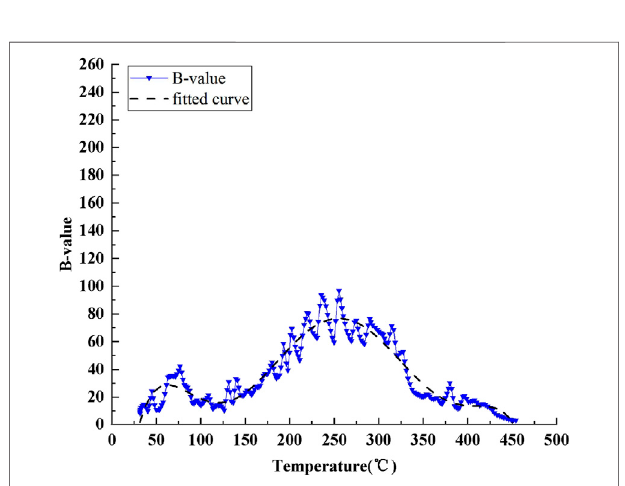
FIGURE 6 | B-value curve and its fi tting curve with temperature